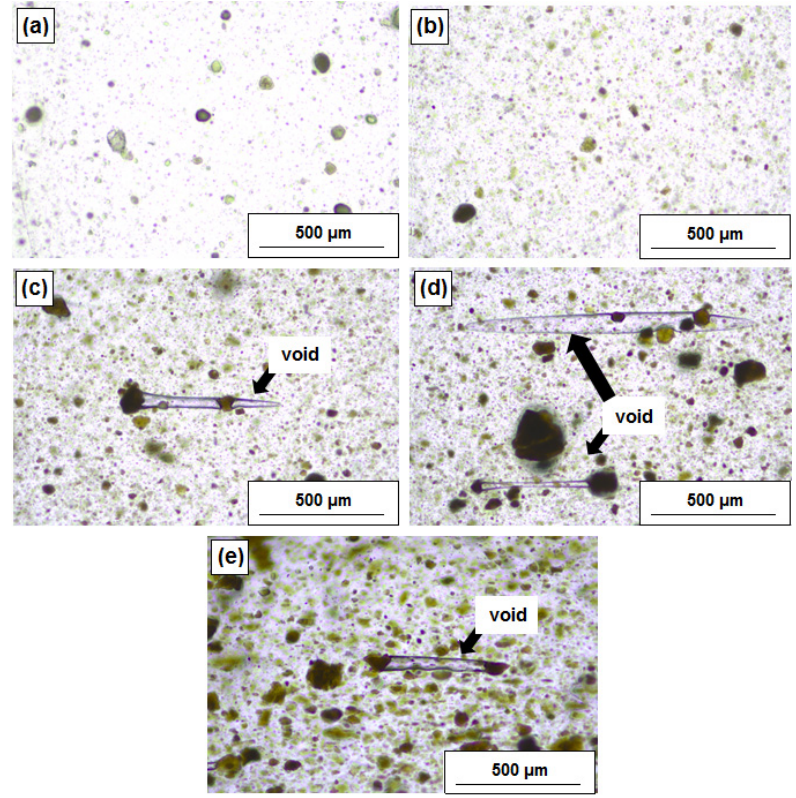
Figure 3. The distribution of MgO, lignin and MgO-lignin hybrid particles in the LDPE matrix observed under higher magnification: LDPE/MgO ( a ), LDPE/MgO-L (5:1 wt./wt.) ( b ), LDPE/MgO-L (1:1 wt./wt.) ( c ), LDPE/MgO-L (1:5 wt./wt.) ( d ) and LDPE/lignin ( e ).